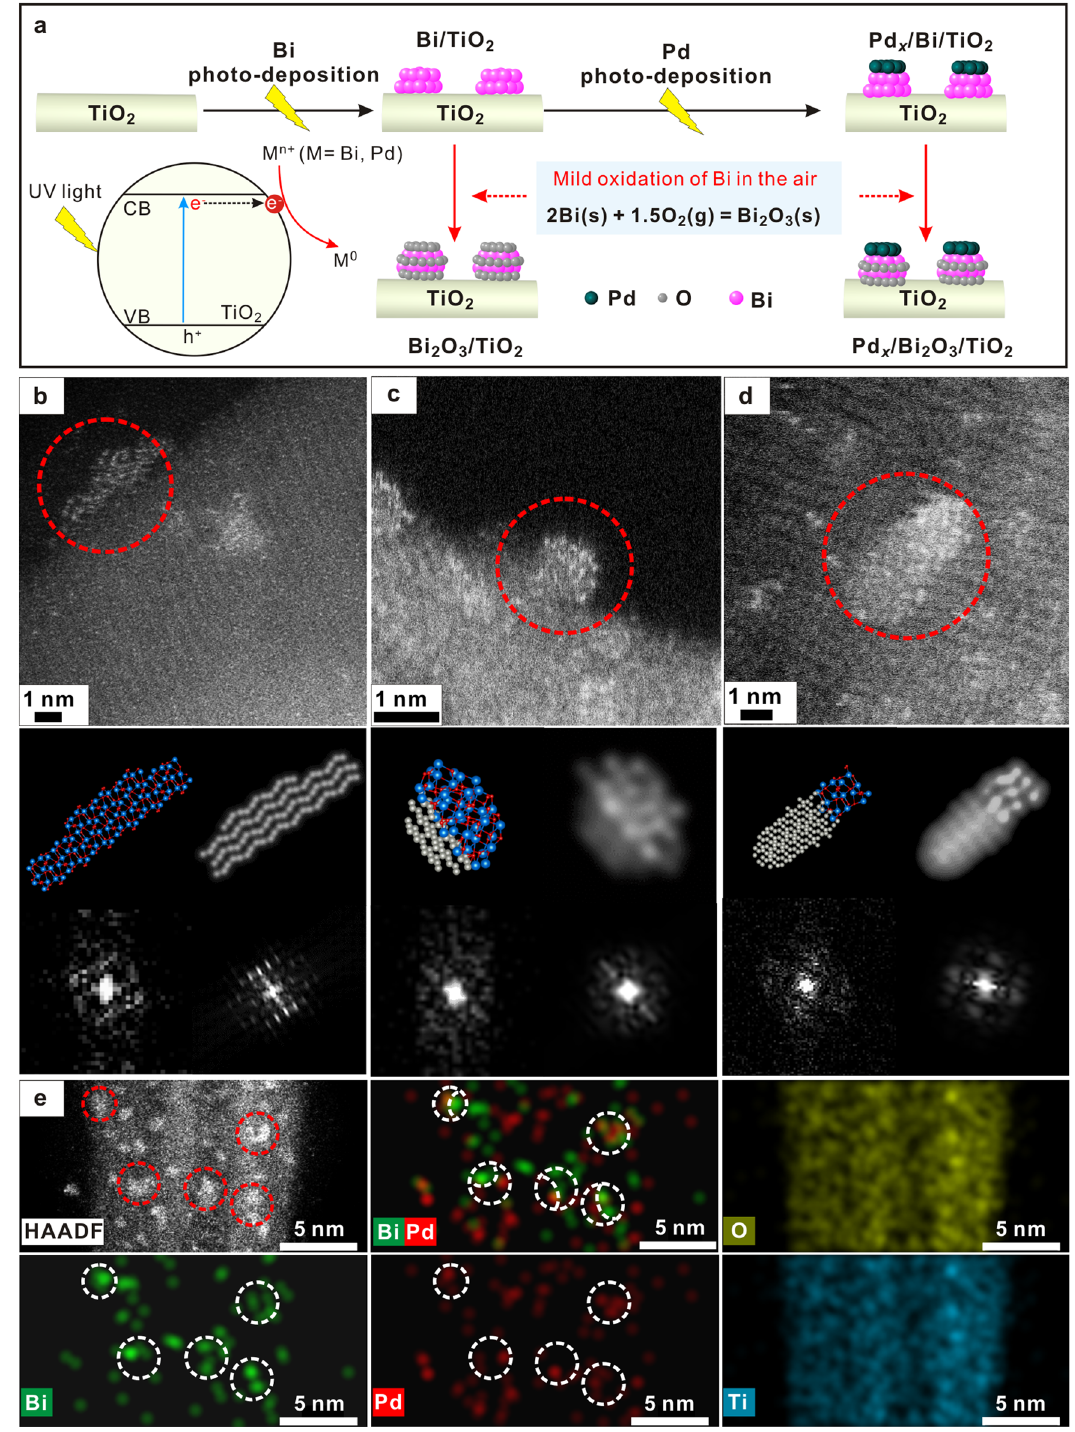
Fig. 1 Microstructure of Pd 1.0 /Bi 2 O 3 /TiO 2 . a Schematic illustration of the synthetic procedures. b – d STEM images of Bi 2 O 3 /TiO 2 ( b ) and Pd 1.0 /Bi 2 O 3 / TiO 2 ( c , d ). The insets from upper to lower and left to right: HRSTEM images, projected structural models, simulated ADF-STEM images, FFTs from dashed circular regions in HRSTEM images, and FFTs from simulated ADF-STEM images, respectively. e Elemental mapping of Pd 1.0 /Bi 2 O 3 /TiO 2